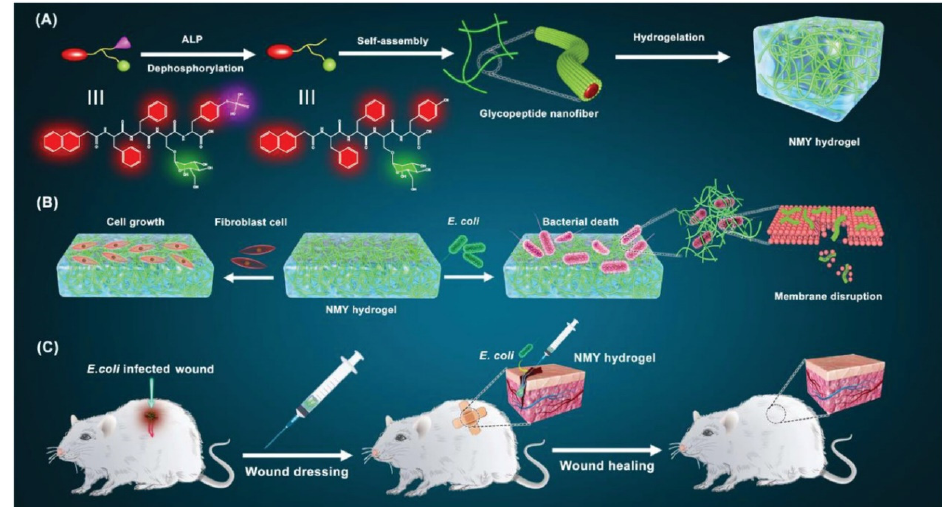
Figure 70. Enzyme instructed self-assembly of a hydrogelator and its applications. ( a ) Enzyme instructed self-assembly of the glycopeptide gelator forming a fibrous network within the hydrogel; ( b ) Impact of the hydrogel on the growth of fibroblast cells and E. coli ; ( c ) Prospective usage of the hydrogel for wound healing applications in a mouse model. Reprinted with permission from [125]. Copyright 2019 Jon Wiley and Sons, Inc.